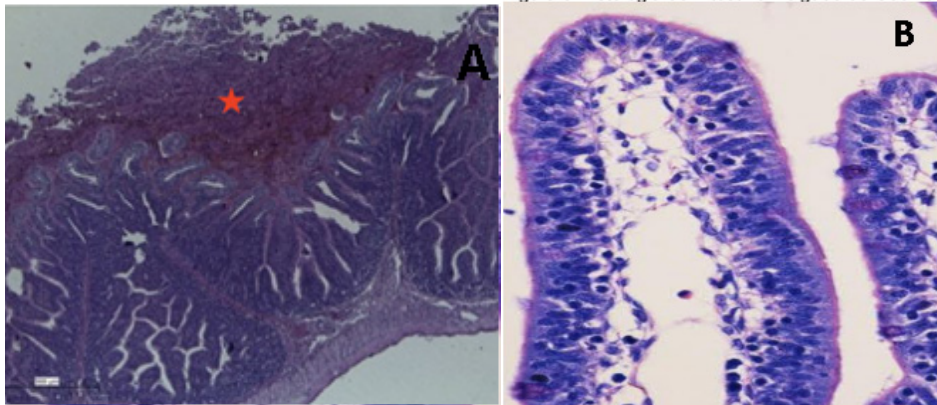
Figure 5. Ileal histopathology of an experimentally inoculated rabbit, 12 h after the inoculation of the AB170 strain. ( A ) Ileal loop showing erythrocytes and debris in the lumen (Red star). HE × 100. ( B ) Negative control. Intestinal tissue is preserved, HE × 200.